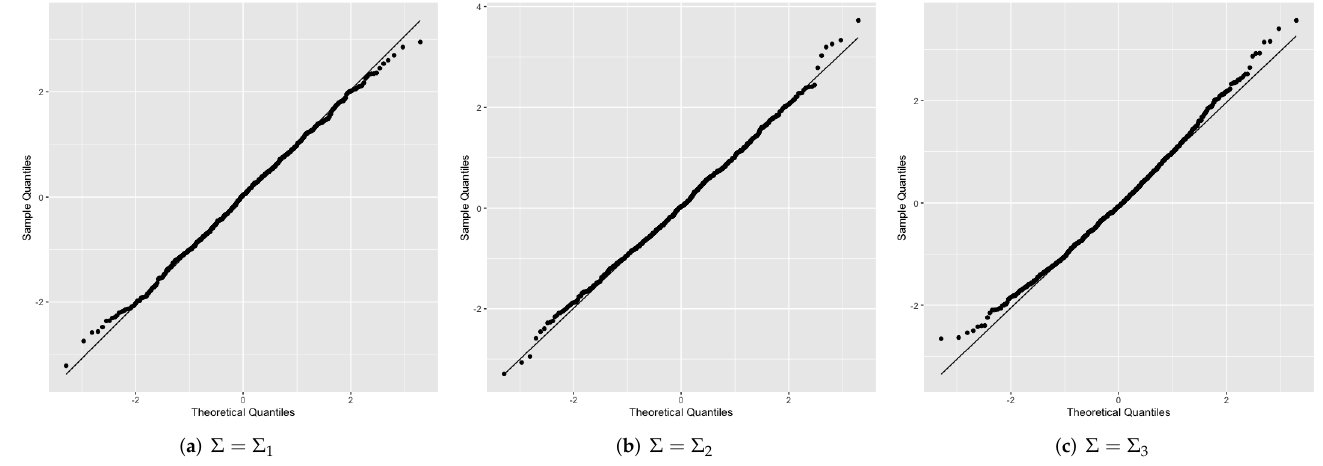
Figure 1. Quantile–Quantile plot of asymptotic distribution for T PBF under the null hypothesis µ 1 = µ 2 against N ( 0,1 ) for different Σ based on 1000 independently generated T PBF with n 1 = n 2 = 70, p =